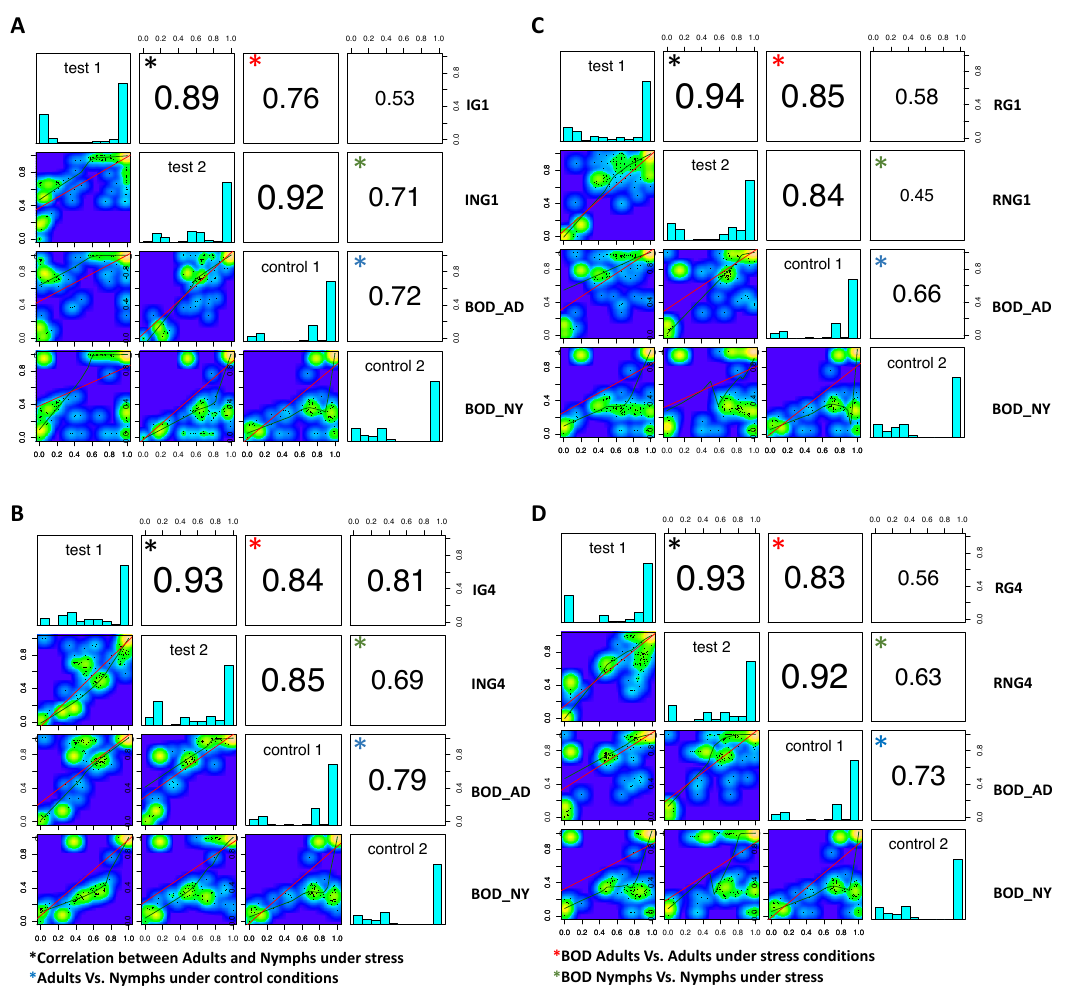
Figure 7. Correlation matrix and scatter plots showing Pearson correlation of CpG methylation (for each cytosine), across BPH populations, analysed in the present study. ( A ) BPH populations under imidacloprid stress (1st generation). ( B ) BPH populations under imidacloprid stress (4th generation). ( C ) BPH populations feeding on RH (1st generation). ( D ) BPH populations feeding on RH (4th generation). Numbers on the upper right corner denote pair-wise Pearson’s correlation scores across samples. The histograms on the diagonal represent CpG methylation level of each sample from 0% to 100% distributed across 10 bins of 10% intervals. Most of the bases have either high or low methylation. The red and green lines on the scatter plots represent linear regression and loess fit, respectively, to model the relationship of differential CpG methylation sites between the compared